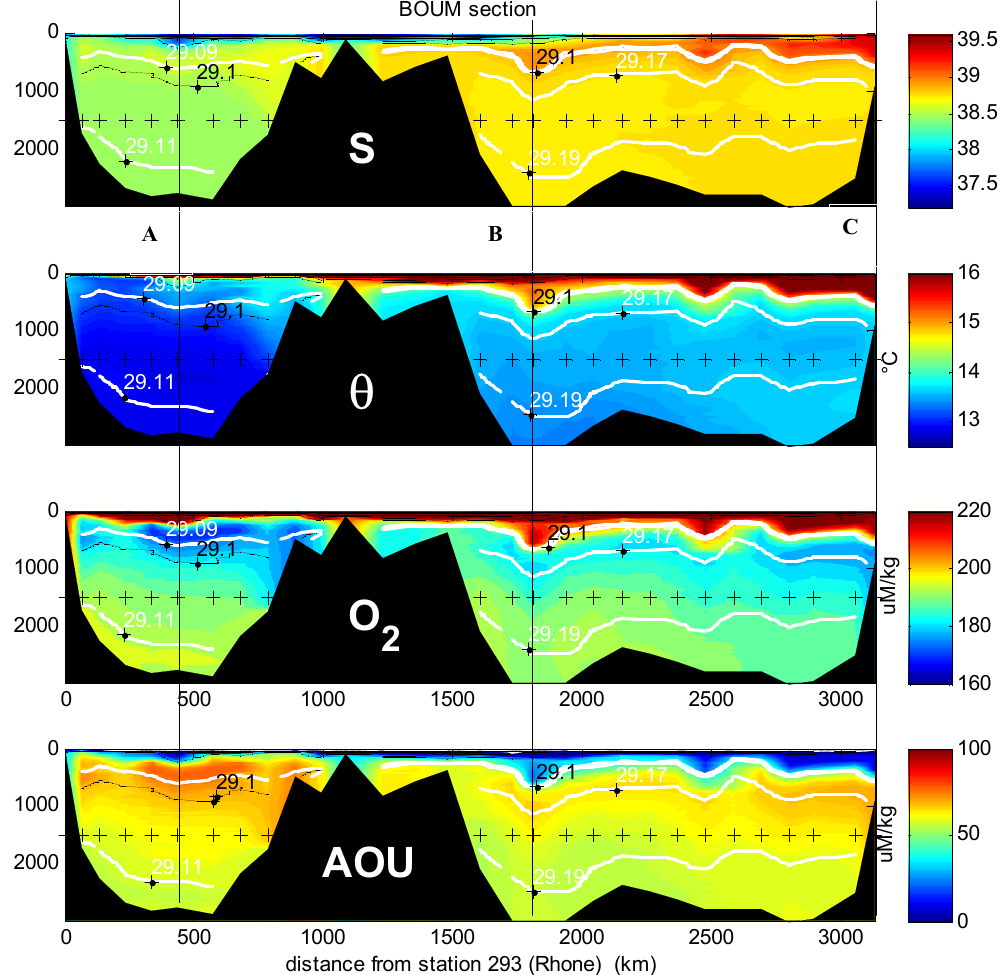
Fig. 4. Salinity ( S , PSU), potential temperature ( θ , ◦ C), dissolved oxygen concentration and apparent oxygen utilization (O 2 and AOU, µmolkg − 1 ) sections along the BOUM transect (0–3000dbars) from the Rhˆone river mouth in the western part of the MS to the Eratosthenes Seamount in the eastern part. Black vertical lines indicate the location of the three LD stations A, B, and C. Specific isopycnals ( σ θ ) are superimposed in thick white on each panels, 29.09, 29.11, 29.17, and 29.19kgm − 3 for the western and eastern basins, respectively, and each decreasing at a 0.5 interval from 29.1 in thin black lines visible only by